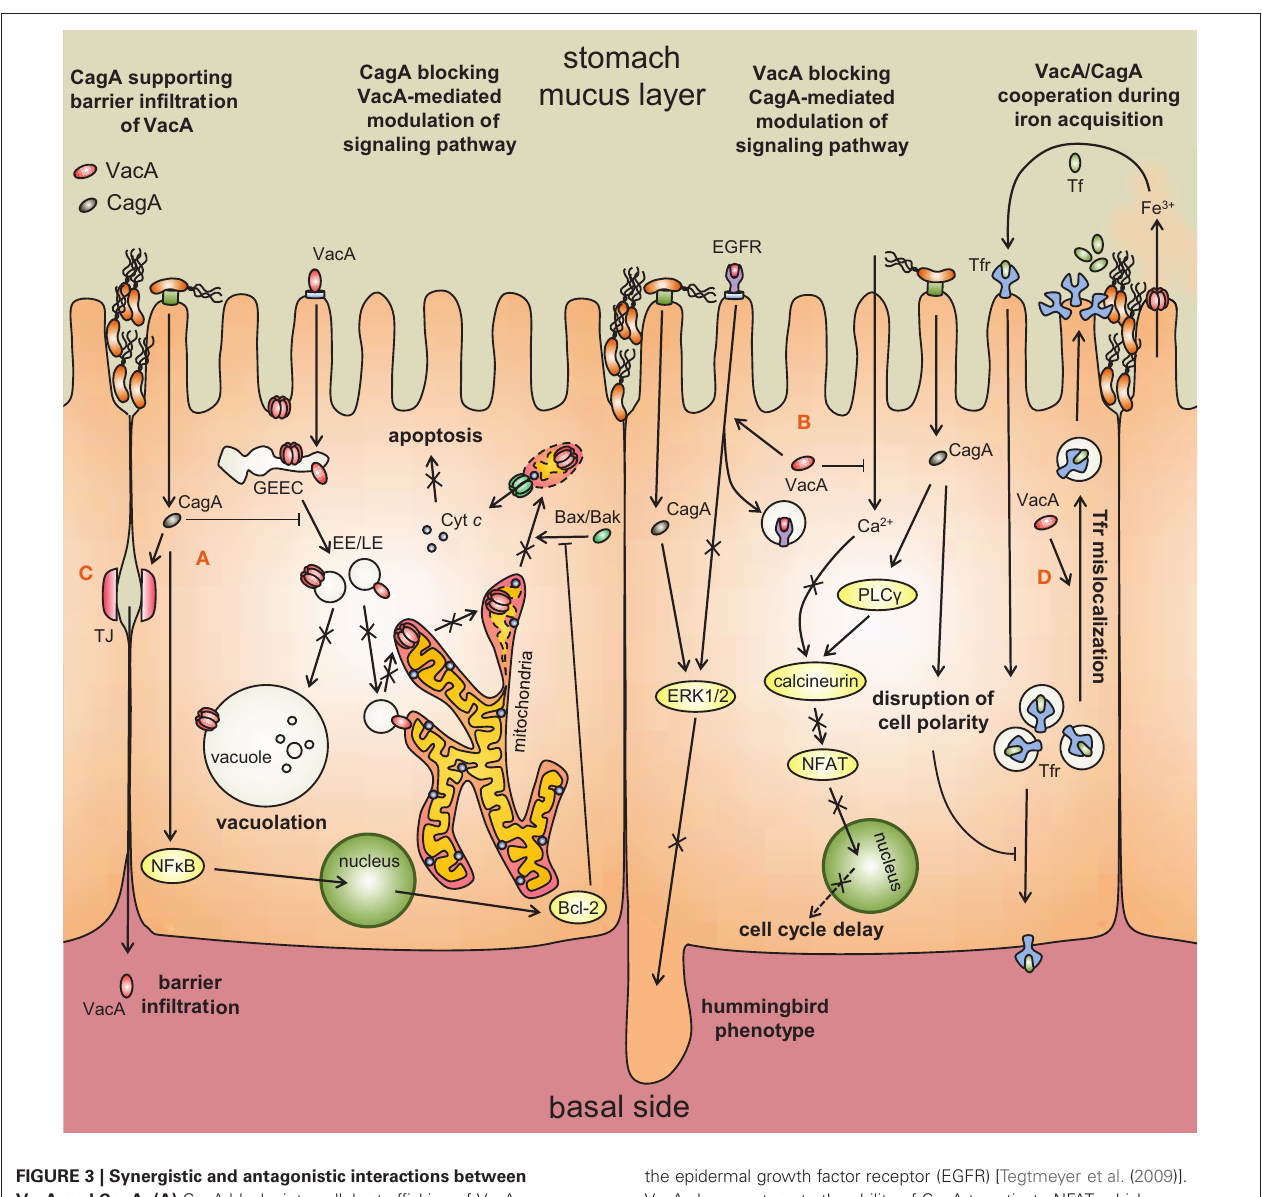
FIGURE 3 | Synergistic and antagonistic interactions between VacA and CagA. (A) CagA blocks intracellular trafficking of VacA [Oldani et al. (2009)], thereby inhibiting VacA-mediated vacuolation and apoptosis [Argent et al. (2008); Oldani et al. (2009)]. VacA-dependent apoptosis is further antagonized by CagA activation of Bcl-2 [Oldani et al. (2009)]. (B) VacA prevents CagA-mediated activation of ERK1/2 and hummingbird-like cellular morphological changes by misrouting